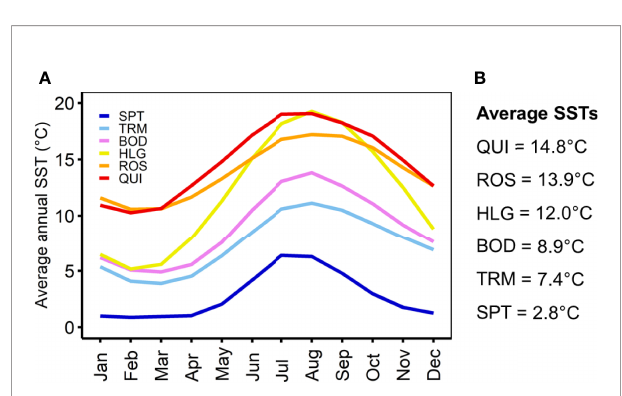
FIGURE 2 | (A) Average annual sea surface temperatures (SSTs) for each month between 2010 and 2020 and (B) overall averages between 2010 and 2020. Satellite-derived data were obtained from the E.U. Copernicus Marine Service (2021). SPT, Spitsbergen; TRM, Tromsø; BOD, Bodø; HLG, Helgoland; ROS, Roscoff; QUI, Quiberon.